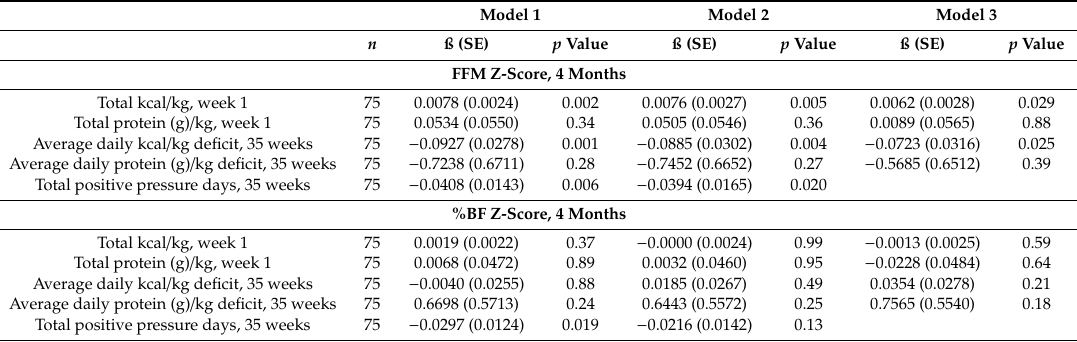
Table 3. Associations between Nutrient intake, Early and Chronic illness and Body composition z-scores at four months CA among VLBW preterm